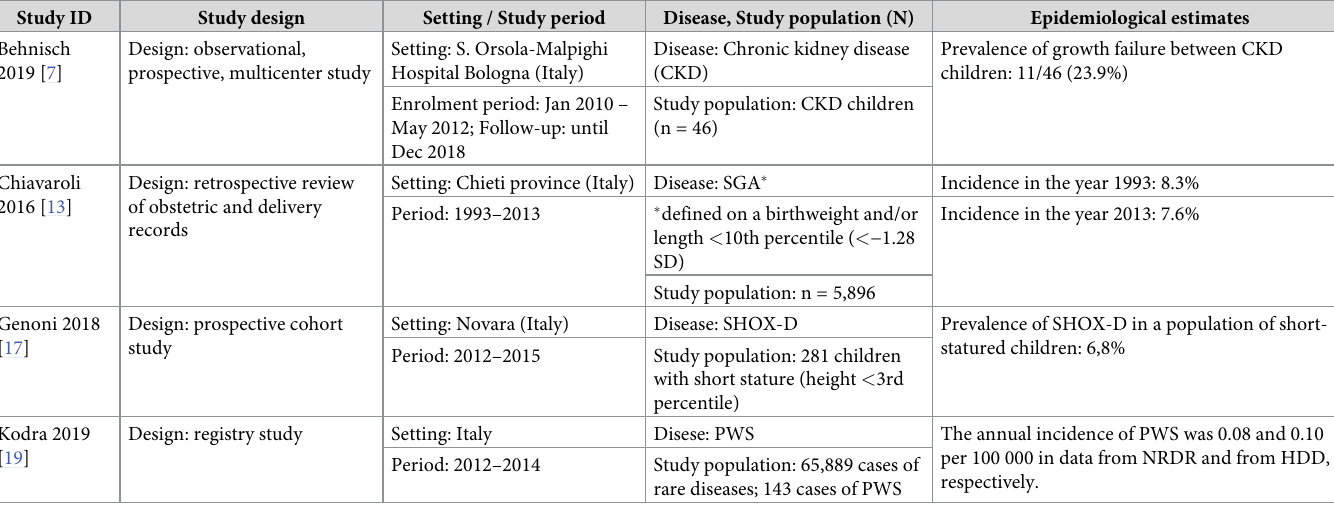
Table 2. Characteristics of included primary studies for